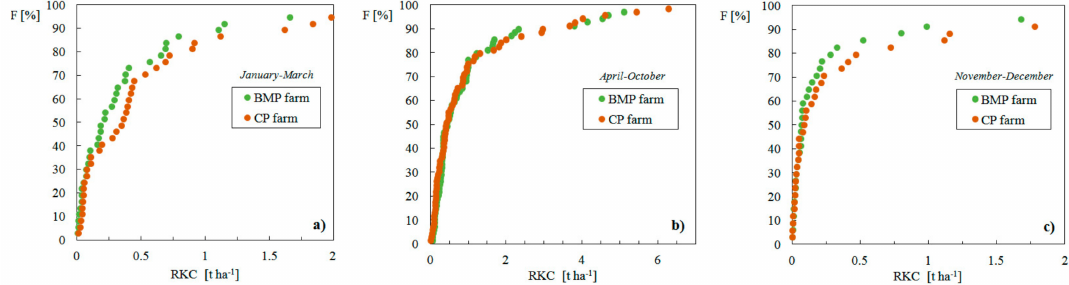
Figure 9. Seasonal distributions of soil loss per unit LS and P, RKC (see RUSLE model), for the two investigated plots. F is the frequency of non-exceedance. ( a ) January–March period, ( b ) April–October period, ( c ) November–December